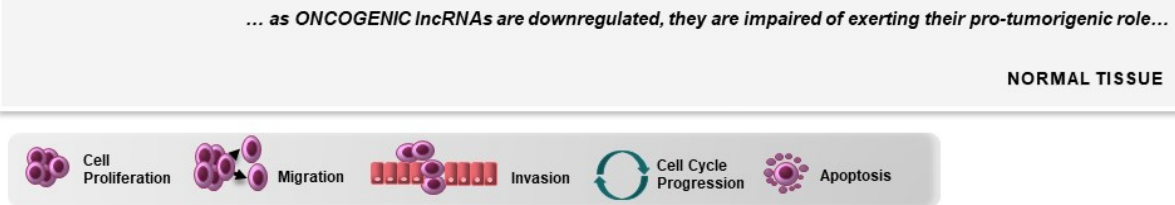
Figure 3. LncRNA-mediated ceRNA crosstalk in normal cervical tissue. Some lncRNAs, such as GAS5, PTENP1, STXBP5- AS1, TUSC8, WT1-AS, and ZNF667-AS1, are abundant in a normal cervical cell and may compete for ‘matching’ miRNA(s), acting as molecular sponges, indirectly regulating protein-coding gene expression by increasing translation. Consequently, through such interactions, they seem to inhibit abnormal cell proliferation and migration/invasion and to stimulate apoptosis, ultimately maintaining cervical tissue homeostasis. Note that as oncogenic lncRNAs such as HOTAIR, MALAT1, NEAT1, OIP5-AS1, and XIST are downregulated in normal cervical tumoral tissue, they are impaired from exerting a protumorigenic effect through different lncRNA-mediated ceRNA networks. Potential target mRNAs are represented by a question mark (?) in order to emphasize that, although they have not yet been investigated by the included references, they probably present a deregulated pattern of expression, as observed for the respective proteins coded by these genes.